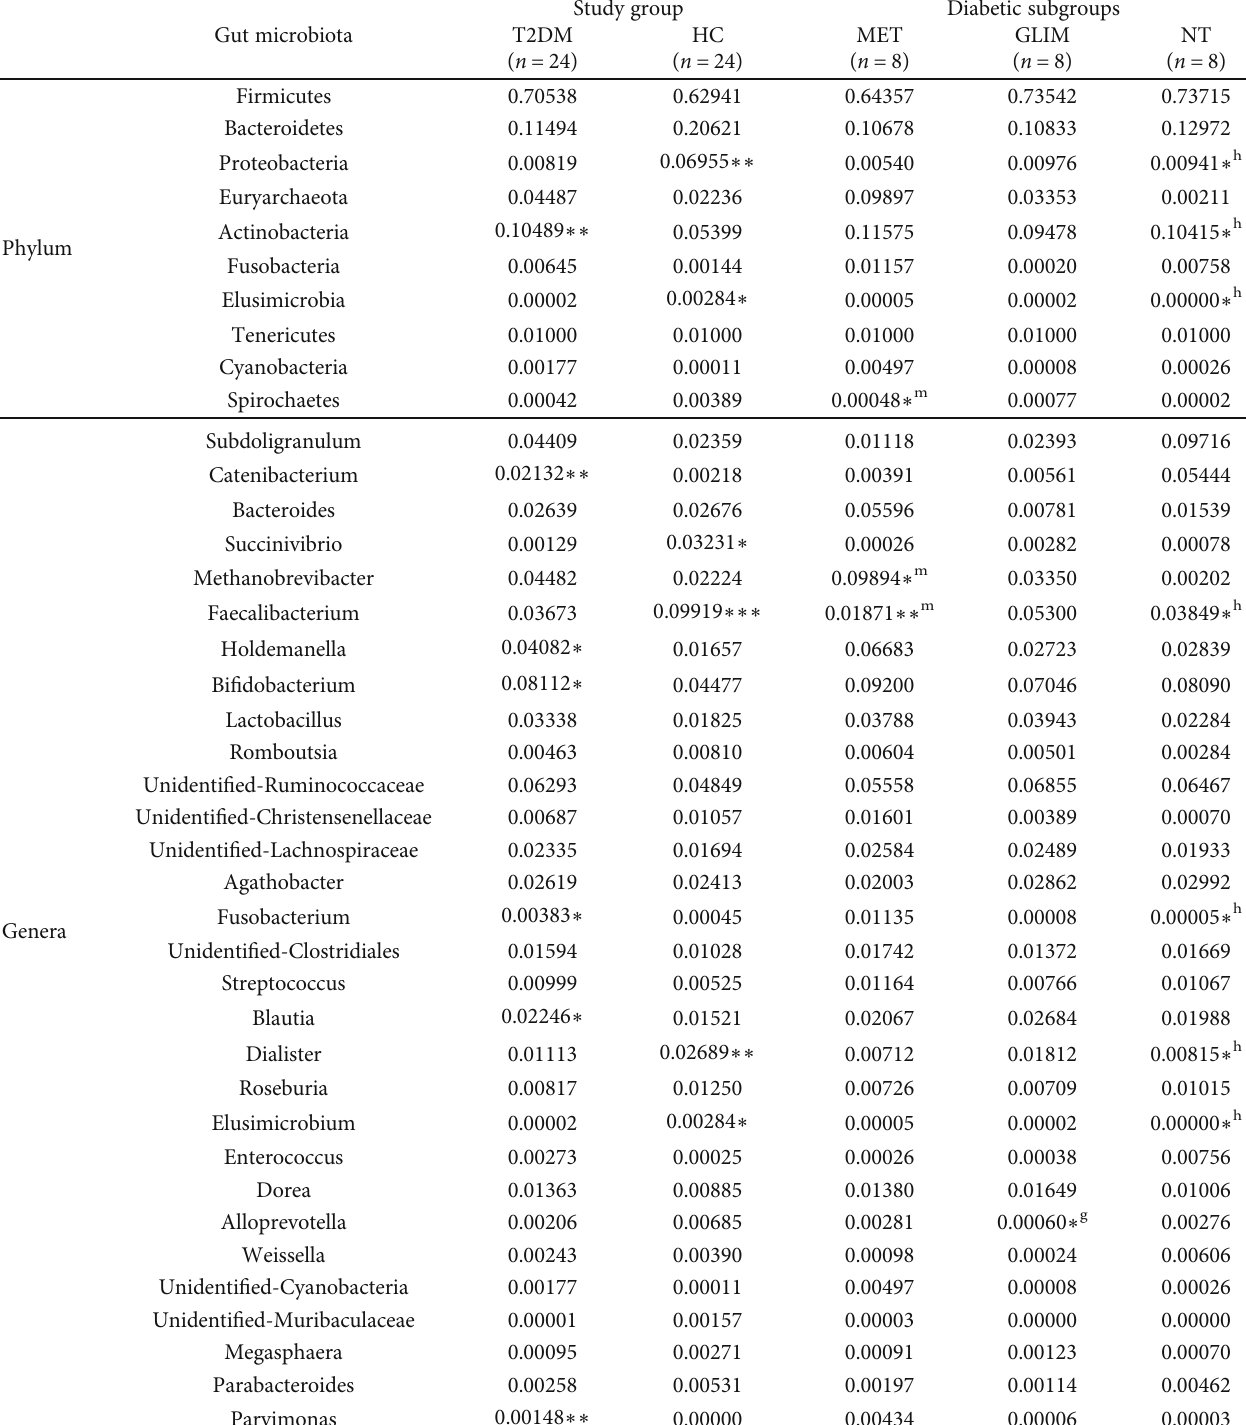
Table 3: Di ff erence of relative abundance phylum and genera between healthy and T2DM individuals and the in fl uence of T2DM and antidiabetic agents on relative abundance